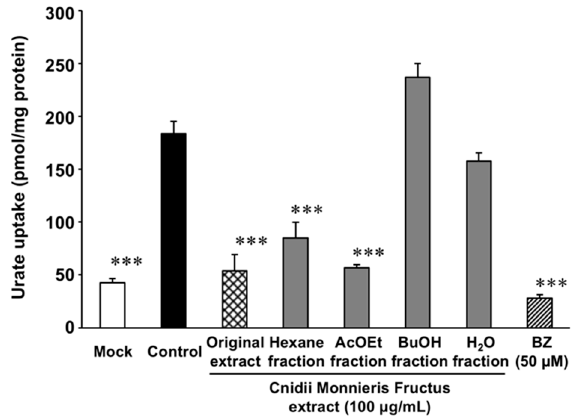
Figure 3. Effect of Cnidii Monnieris Fructus extract and its fractions on the uptake of uric acid via URAT1. HEK293/PDZK1 cells were transiently transfected with human URAT1. Cells were incubated with uric acid (11.6 µ M) with or without the extract and its fractions at the concentrations related to Cnidii Monnieris Fructus extract (100 µ g/mL), respectively, at 37 ◦ C for 30 min, and the uptakes of uric acid into the cells were measured. Data are expressed as the mean ± S.E. ( n = 3). 50 µ M of BZ was used as a positive control. *** p < 0.001 vs. the control group by ANOVA and Bonferroni–Dunnett’s multiple t